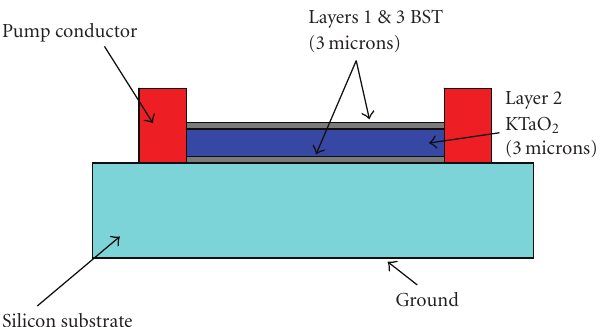
Figure 6: Geometry of a multilayer BRF.